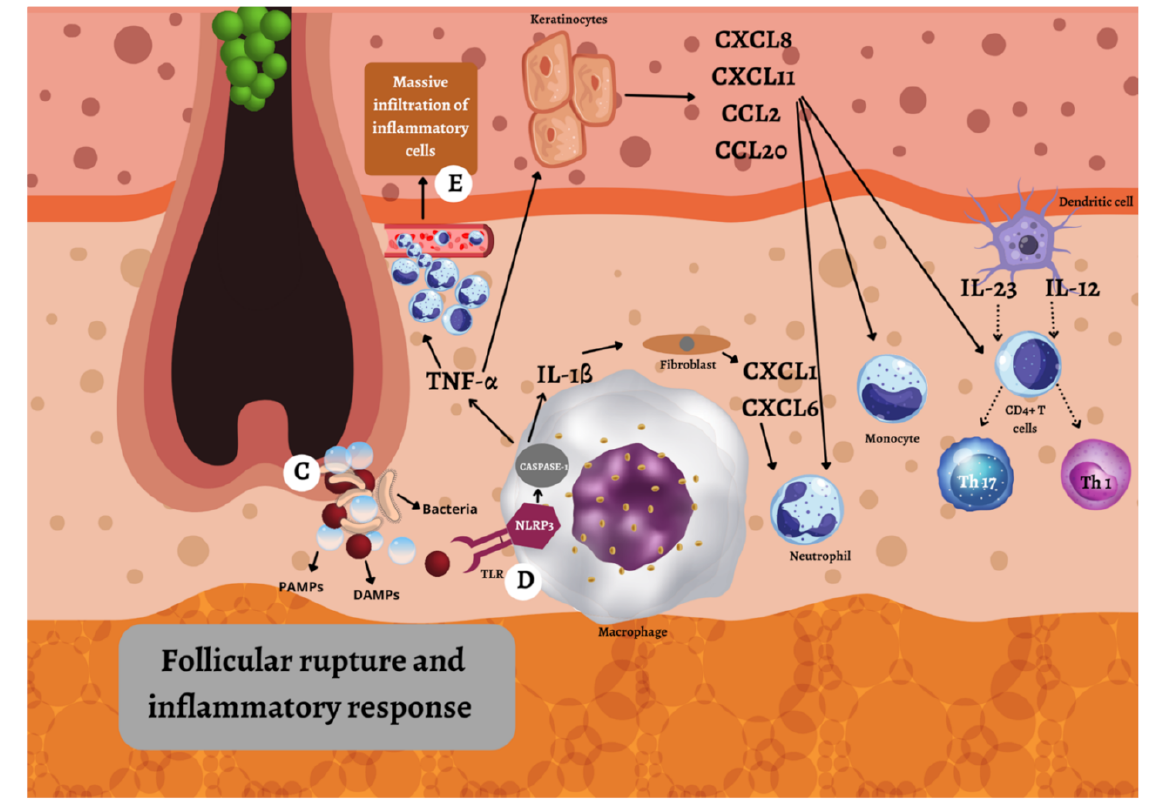
Figure 2. The second event is the rupture of the dilated follicle (C), and dispersing the keratin fibers, commensal flora, and PAMPs/DAMPs into the dermis. PAMPs and DAMPs are recognized by macrophages through TLRs and inflammasomes (D). Macrophages are, through TLRs, stimulated to produce TNF- α . The inflammasome is activated through an NLRP3 that senses microbial or damage products. It then mediates activation of caspase-1, which proteolytically cleaves pro-IL1- β into its active form, IL-1 β . IL-1 β activates fibroblasts which produce CXCL1 and CXCL6, and TNF- α activates keratinocytes which produce CXCL8, CXCL11, CCL2, and CCL20. These chemokines recruit more inflammatory cells, mainly neutrophils, monocytes, and subsets of T cells. Massive infiltration of inflammatory cells leads to nodules, abscesses, and fistula formation (E). Activated dendritic cells produce IL-12, which induces Th1 polarization and IL-23, which is responsible for maintenance of the Th17